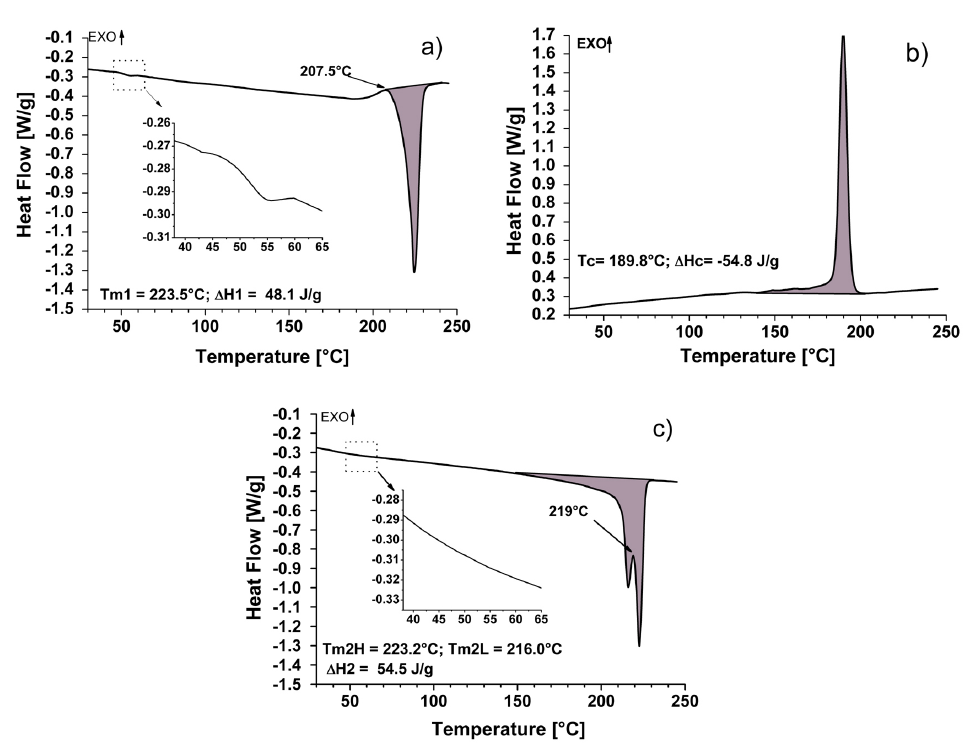
Figure 2. DSC thermograms of the neat PBT after extrusion, where: (a) First heating step, (b) Cooling step, (c) Second heating